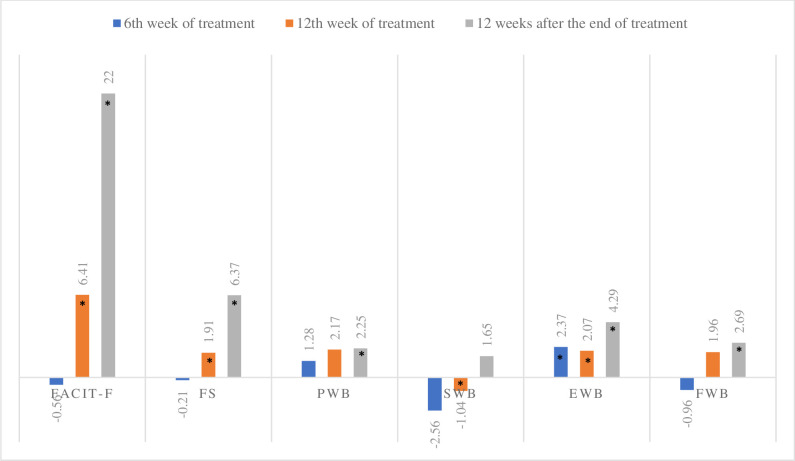
Difference of the mean score in relation to the FACIT-F baseline.Analysis of Student t test to compare the means of week 6 of treatment, week 12 of treatment and 12 weeks after the end of treatment in relation to the baseline scores, * p<0.05. N = 105. FACIT-F, functional assessment of chronic illness therapy-fatigue; FS, fatigue; PWB, physical well-being; SWB, social well-being; EWB, emotional well-being; FWB, functional well-being.